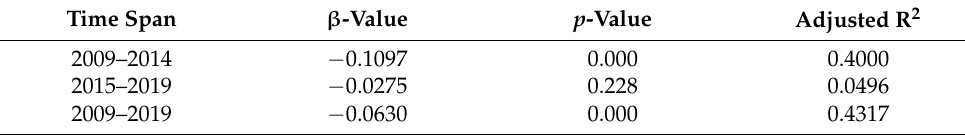
Table 5. Absolute β -convergence test results of cultivated land use efficiency in China. Time Span β -Value p